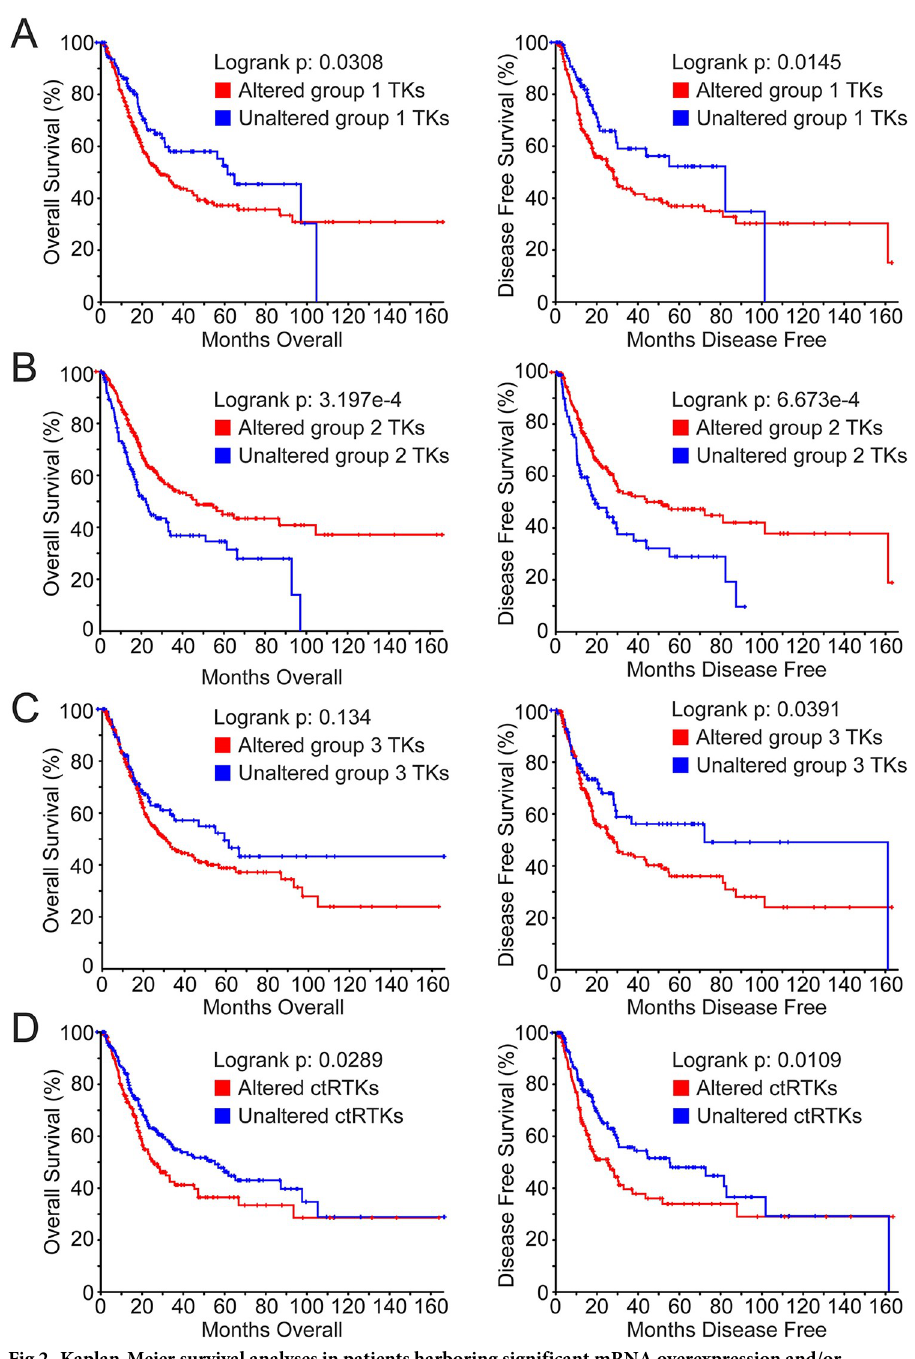
Fig 2. Kaplan-Meier survival analyses in patients harboring significant mRNA overexpression and/or amplification of TK genes. Kaplan-Meier analyses of OS (left panels) and DFS (right panels) in patients harboring significant mRNA overexpression (z-score > 2) and/or amplification of (A) group 1 TKs (red) vs . those without alteration (blue; median OS 28.22 vs . 61.40 mos., log-rank p = 0.0308; median DFS 27.99 vs . 82.42 mos., log-rank p = 0.0145); (B) group 2 TKs (red) vs . those without alteration (blue; 46.65 vs . 22.14 mos., log-rank p = 3.197e-4; median DFS 51.41 vs . 19.05 mos., log-rank p = 6.673e-4); (C) group 3 TKs (red) vs . those without alteration (blue; 30.91 vs . 59.26 mos., log-rank p = 0.134; median DFS 27.99 vs . 72.34 mos., log-rank p = 0.0391); (D) 14 ctRTKs (AXL, CSF1R, FLT3, KDR, MET, MERTK, NTRK1/2/3, RET, ROS1, TEK, DDR2 and TYRO3; red) vs . those without alteration (blue; 25.56 vs . 54.86 mos., log-rank p = 0.0289; median DFS 25.23 vs . 55.16 mos., log-rank p = 0.0109).